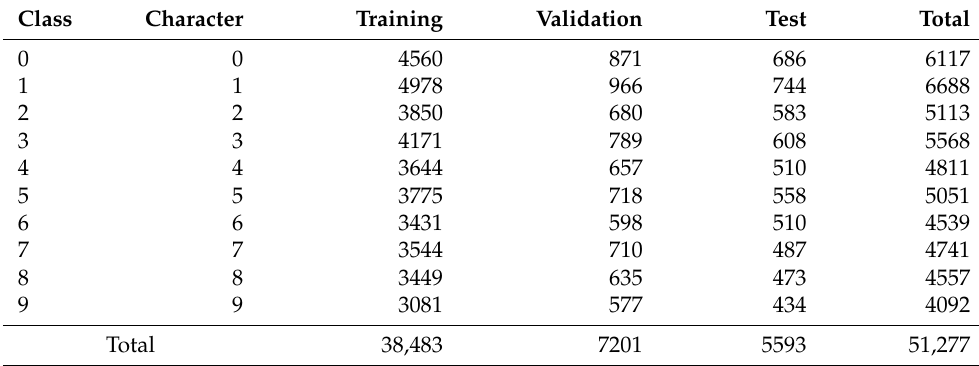
Figure 8. Different Korean LP styles, including single- and double-line LPs containing Korean characters and numbers listed in Tables 3 and 4. Table 3. Collected data for Korean LP numbers.